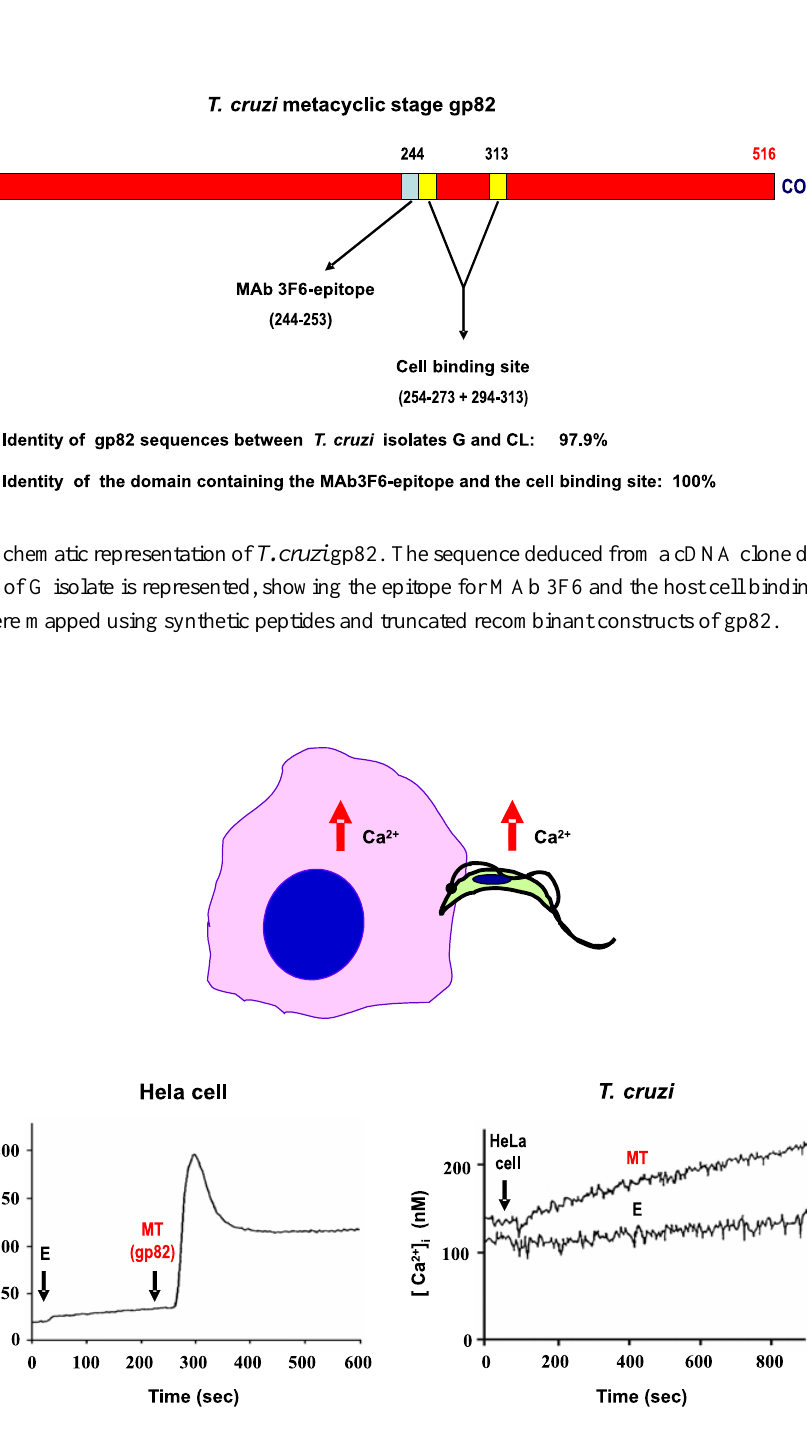
Fig. 4 – Ca 2+ response induced by T. cruzi -host cell interaction. Transient intracellular Ca 2+ mobilization triggered in HeLa cells upon addition, at the indicated time (arrow), of sonicated extract of MT or purified native gp82, is shown on the left. Note the lack of response by addition of non-infective epimastigote (E) extract. Shown on the right is the Ca 2+ response induced in MT, but not in E, by sonicated HeLa cell